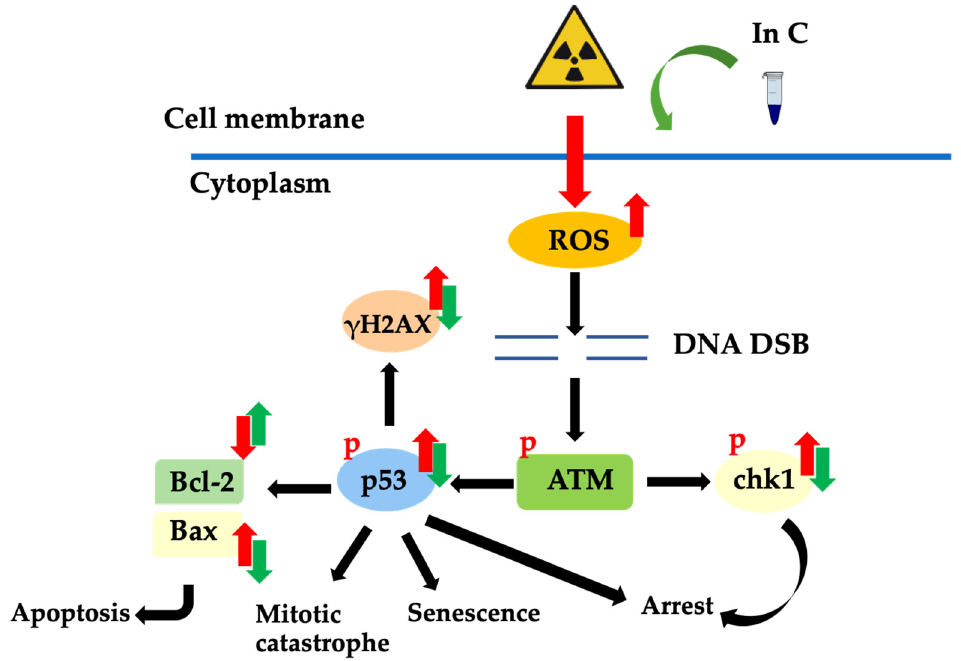
Figure 8. Downstream molecules and effects following DNA damage due to ionizing radiation. Reactive oxygen species (ROS) generated after irradiation can disrupt macromolecules, including DNA. This process activates ataxia–telangiectasia-mutated (ATM) and downstream molecules such as p53 and chk1. γ H2AX molecules are key in the response to DNA double-stranded breaks (DSB). When cell death occurs via apoptosis, pro-apoptosis proteins are increased, and anti-apoptosis proteins are decreased. Interruptin C can protect cells from radiation by decreasing DNA damage, enhancing DNA repair, inducing anti-apoptosis proteins, and reducing pro-apoptosis proteins.